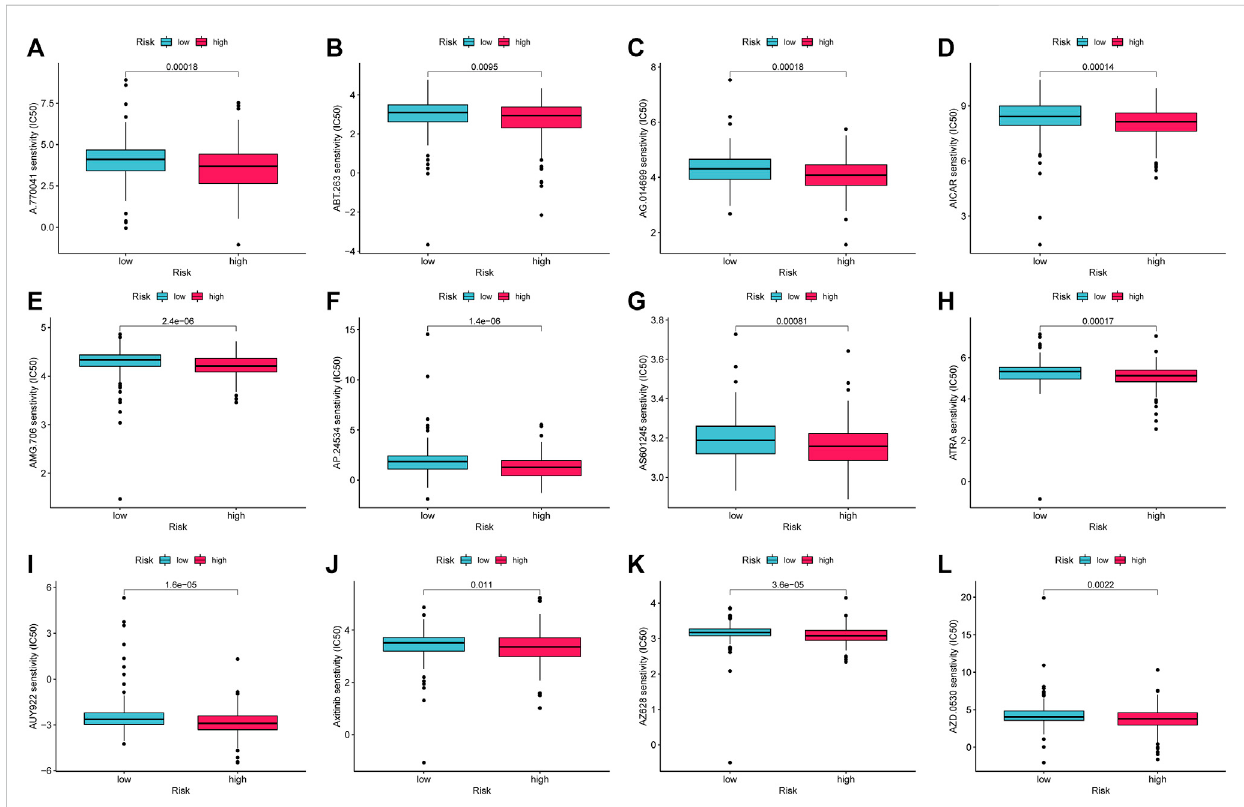
FIGURE 12 Drug candidates targeting AMMLs. IC50s of (A) . (A) 770041 (B) . ABT.263 (C) . AG014699 (D) . AICAR (E) . AMG.706 (F) . AP.24534 (G) . AS601245 (H) . ATRA (I) . AUY922 (J) . Axitinib (K) . AZ628 and (L) . AZD.0530 betweenthe low- and high-risk patients. AMMLs, LncRNAsrelated to amino acid